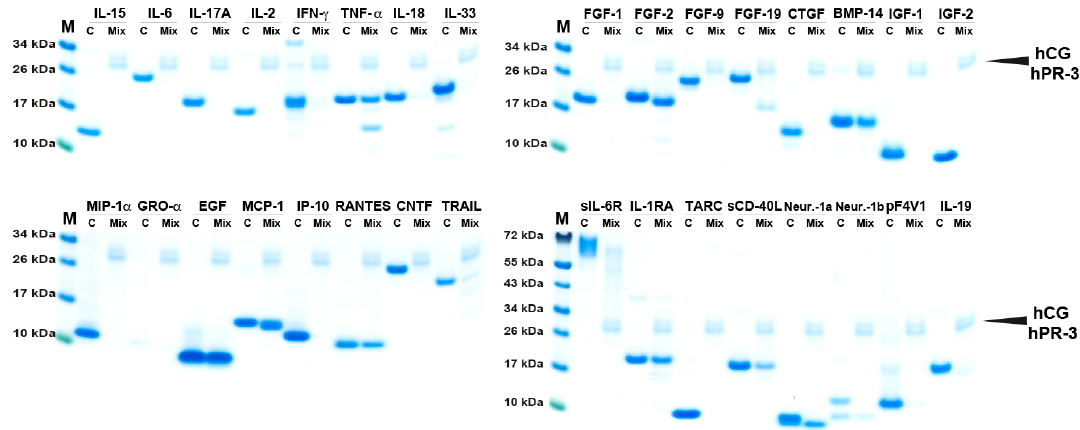
Figure 3. Cleavage analysis of a smaller panel of recombinant human cytokines and chemokines by a combination of three neutrophil proteases. Three micrograms of the various recombinant cytokines and chemokines in buffer solution were divided into two separate tubes. One was kept as negative control (C) where no enzyme was added, one was cleaved with a combination of three neutrophil proteases hNE, hPR3 and hCG. The cleavage was performed at 37 °C for 2.5 h. The samples were separated on 4–12% SDS-PAGE gels under reducing conditions. Size markers are found at the left side of each gel. The gels were stained in colloidal Coomassie blue solution. This analysis was performed only once.